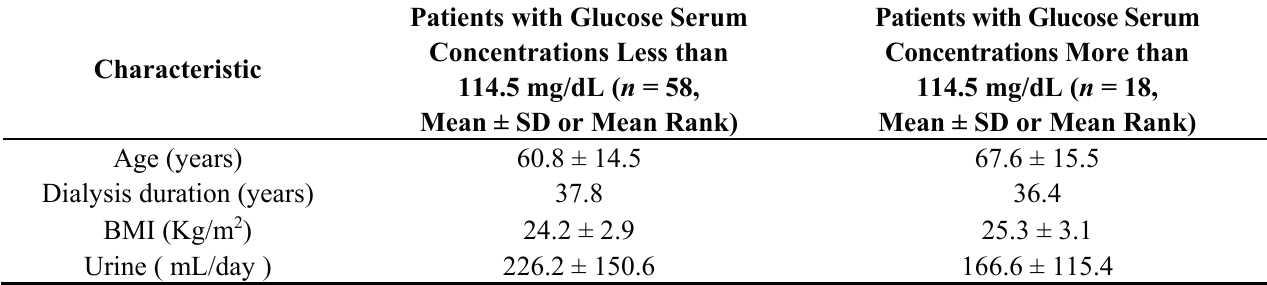
Table 1. Characteristics and differences between groups of patients according to glucose cut off point related to coronary disease (on-line hemodiafiltration, n = 76, *: p < 0.05).